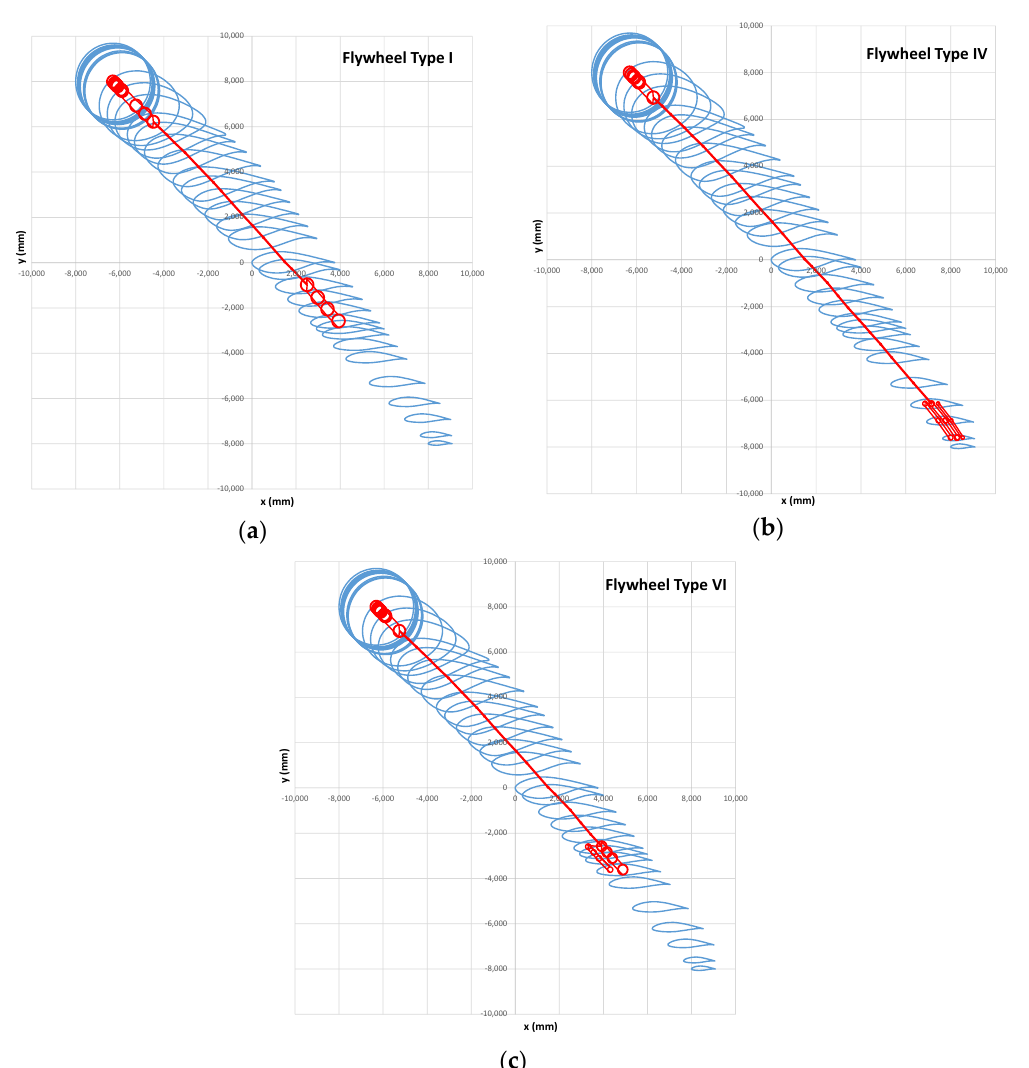
Figure 4. Cross-sections of the Sandia 61.5 m blade at the 38 blade nodes and the piston accumulators with fluid pipe of ( a ) FW type I, ( b ) FW type IV, and ( c ) FW type VI.